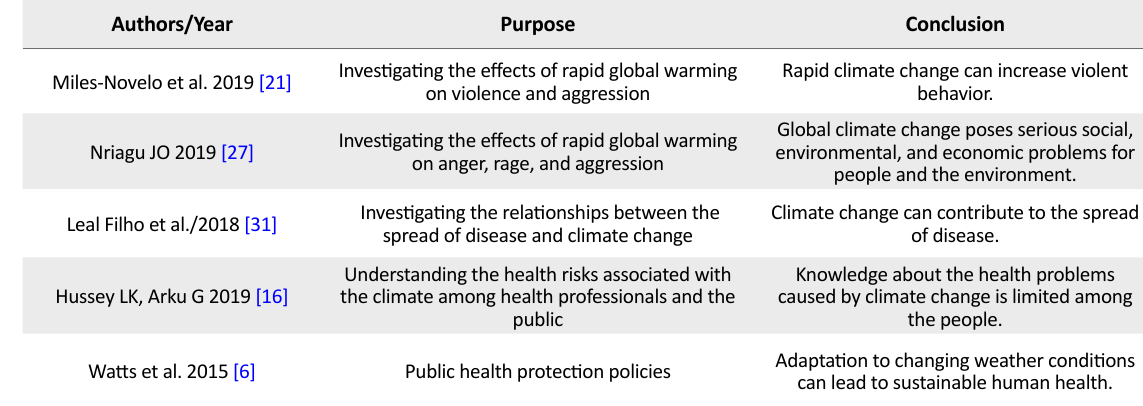
Table 2. Summary for the effects of climate change on human